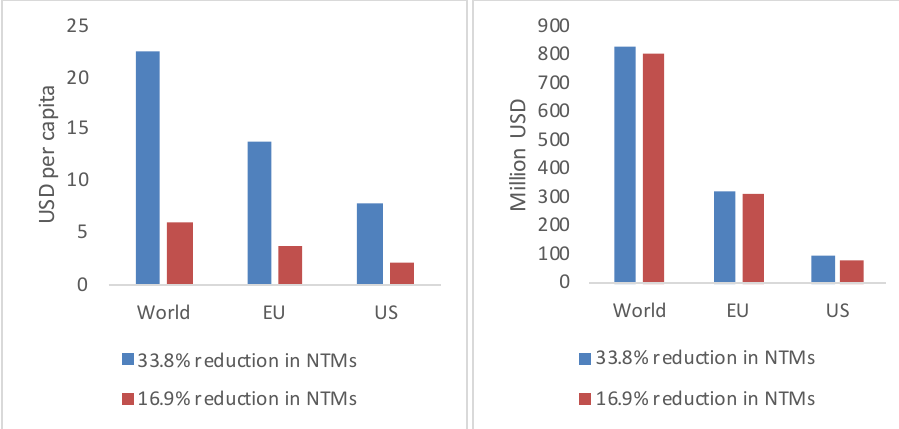
Source: Simulation